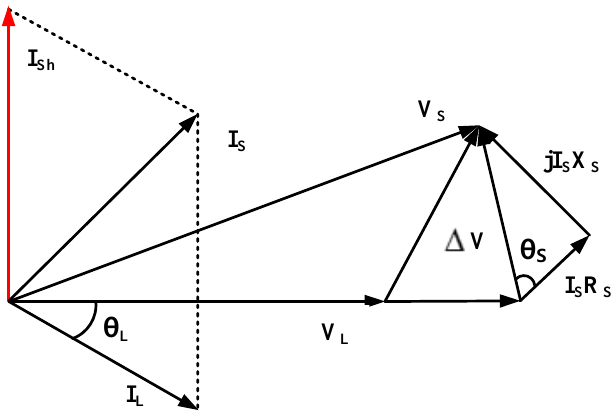
Figure 2. Vector Diagram of STATCOM Power Quality Compensation.